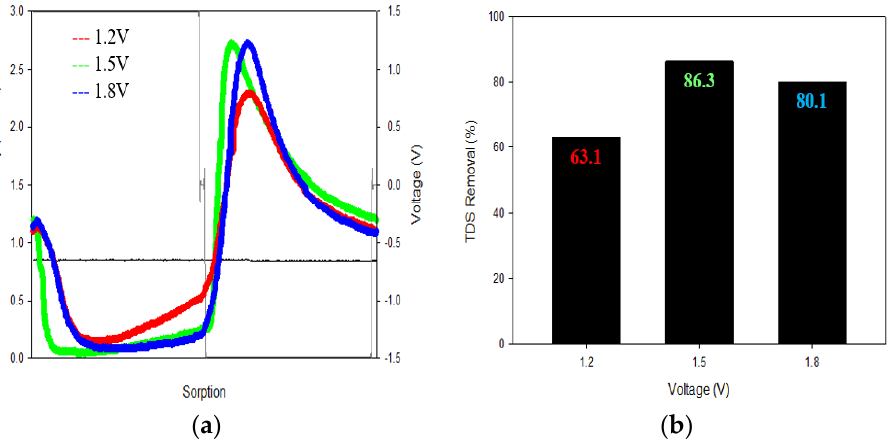
Figure 4. The results of the applied voltage of the CDI: ( a ) Voltage was set in 0.3 V increments from 1.2 V to 1.8 V; ( b ) The TDS removal rate was the highest at 86.3% at 1.5 V.